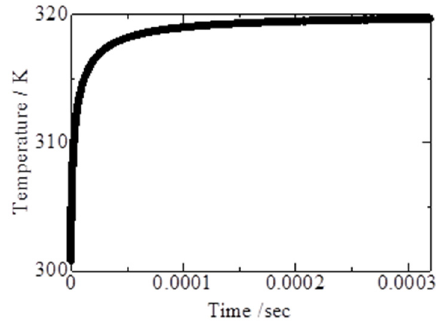
Figure 5. Tracking time of ultrafine wire.